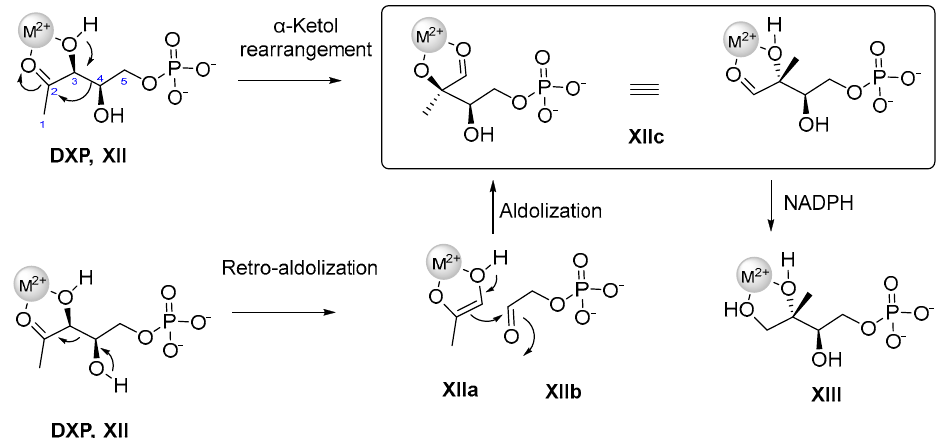
Figure 5 . Two conceivable mechanisms for the enzymatic mode of action of DXR involving a divalent metal cation M 2+ (grey sphere) and NADPH [87] . Used with permission of EUREKA SCIENCE, from Targeting the MethylErythritol Phosphate(MEP) Pathway for Novel Antimalarial, Antibacterial and Herbicidal Drug Discovery: Inhibition of 1-Deoxy-D-Xylulose-5-Phosphate Reductoisomerase (DXR) Enzyme, Nidhi Singh, Volume 13, Issue 11, 2007; permission conveyed through Copyright Clearance Center, Inc.